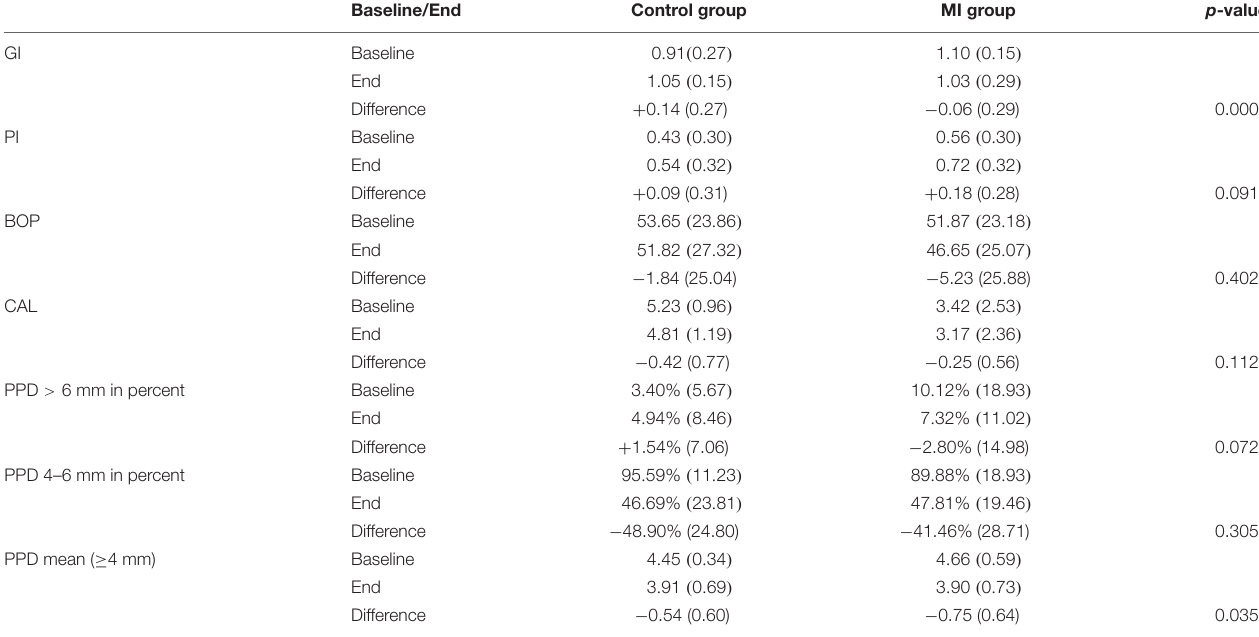
TABLE 3 | Clinical results baseline and after the non-surgical periodontal